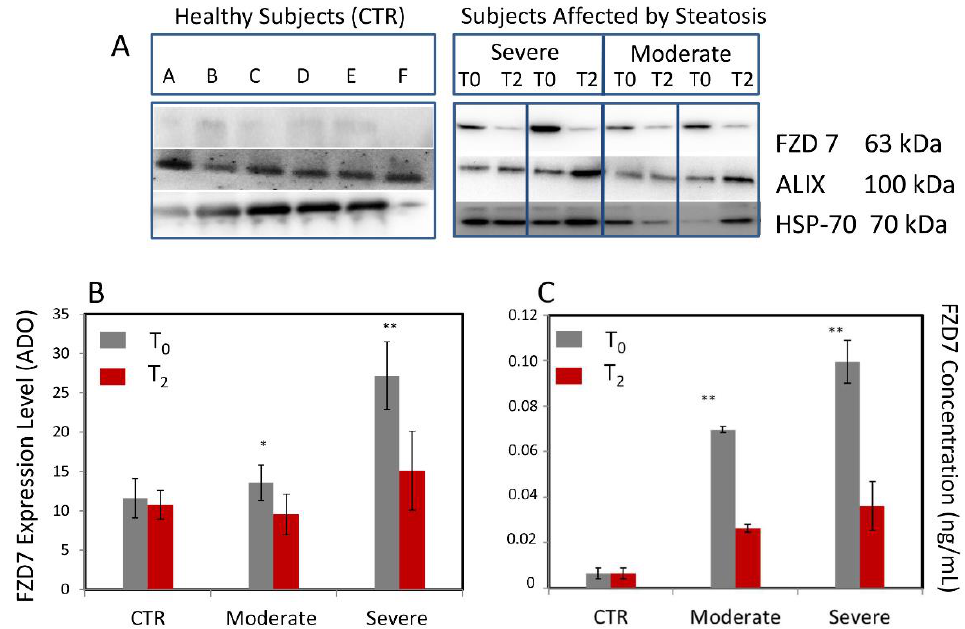
Figure 2. Exosomes extracted from plasma of all healthy subjects (20) and NAFLD-affected patients (95) with moderate (38) or severe (57) hepatic steatosis at recruitment time (T0) and after treatment (T2): ( A ) representative Western Blotting of FZD7, ALIX, and HSP-70 (molecular mass markers are indicated on the right); ( B ) semi-quantitative estimation, by Western blotting analysis and densitometry of protein bands, of relative FZD7 expression level; ( C ) quantitative analysis of FZD7 by ELISA assay. For semiquantitative analysis, the same total protein content (20 µ g) was loaded and FZD7 bands were evaluated upon normalization with the corresponding housekeeping ALIX protein band for each sample. * p < 0.05 and ** p < 0.001 versus control.